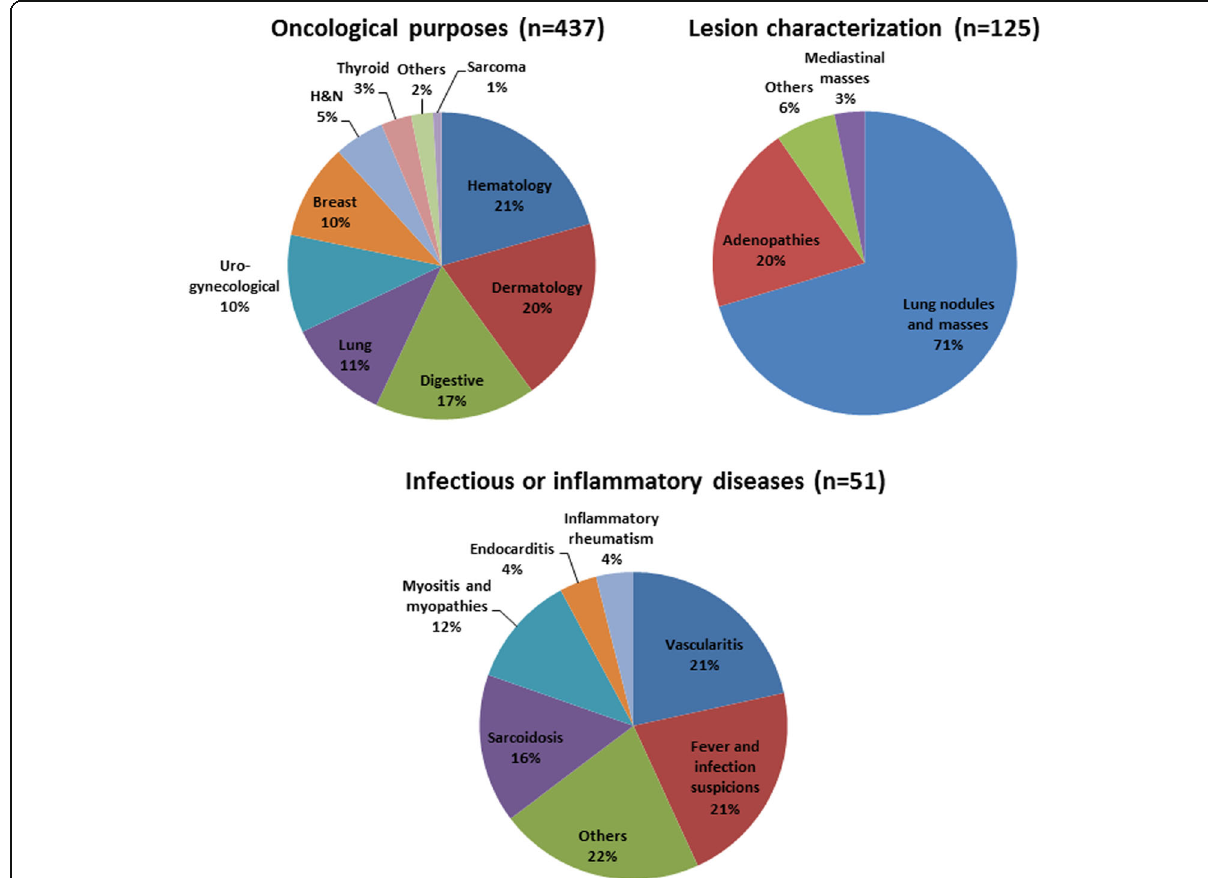
Fig. 1 Additional details on PET examinations